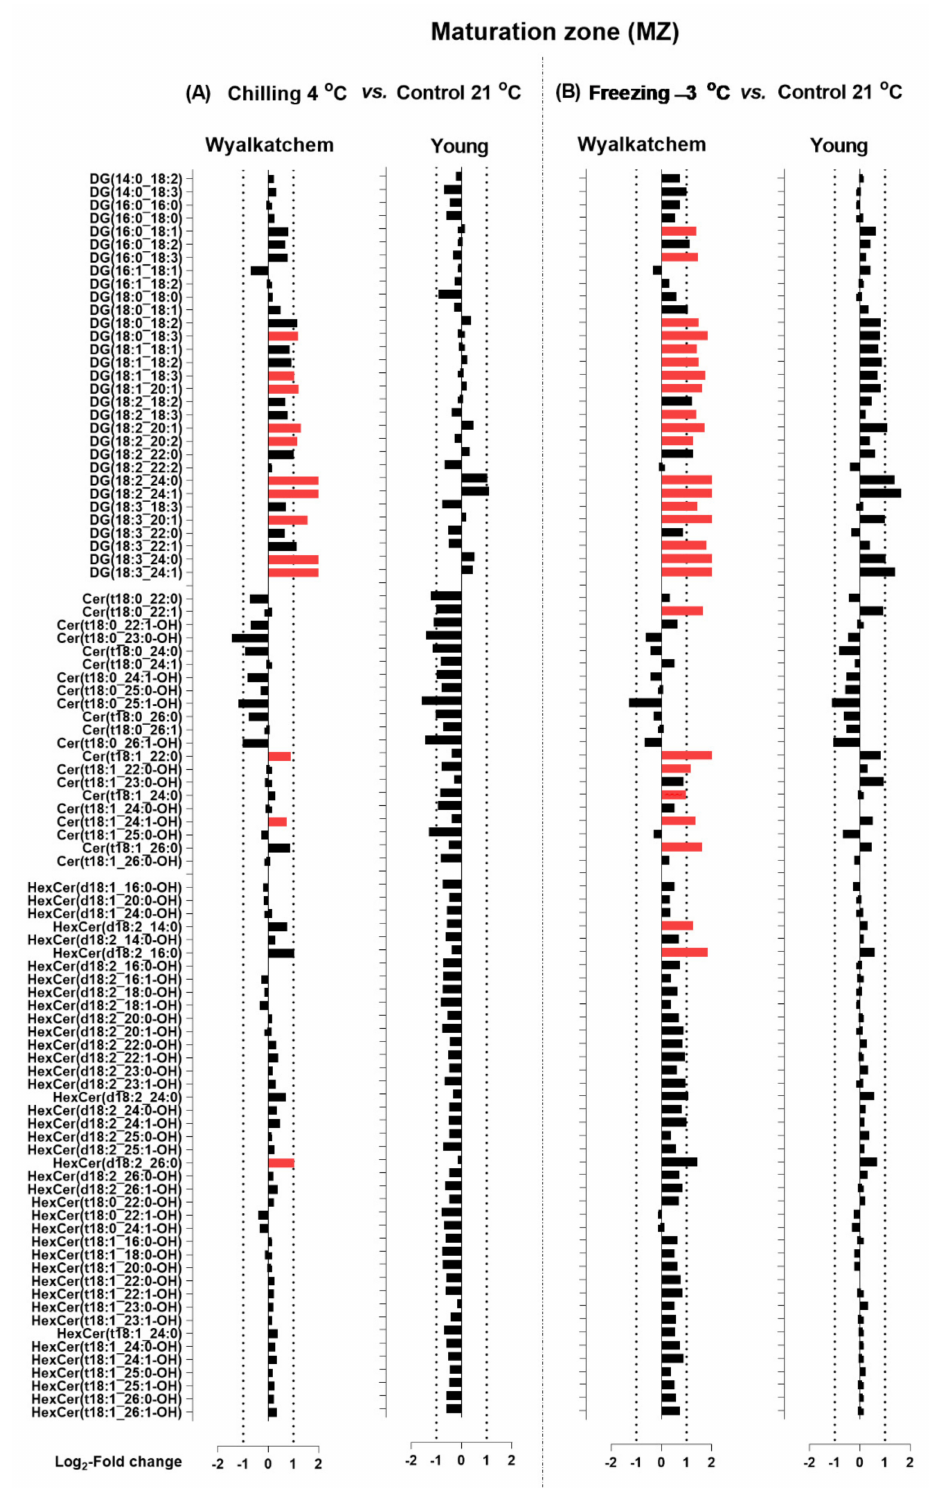
Figure 9. Log 2 -fold changes of DG, Cer and HexCer species in the maturation zone (MZ) of the cold-sensitive Wyalkatchem and cold-tolerant Young after exposed to ( A ) chilling and ( B ) freezing stresses. Statistical significance was determined using an FDR-adjusted p -value of 0.05 as the cut-off. Green bar = significant decrease; Red bar = significant increase. Black bar represents lipid species that has no significant change after cold stress as compared to control. n =